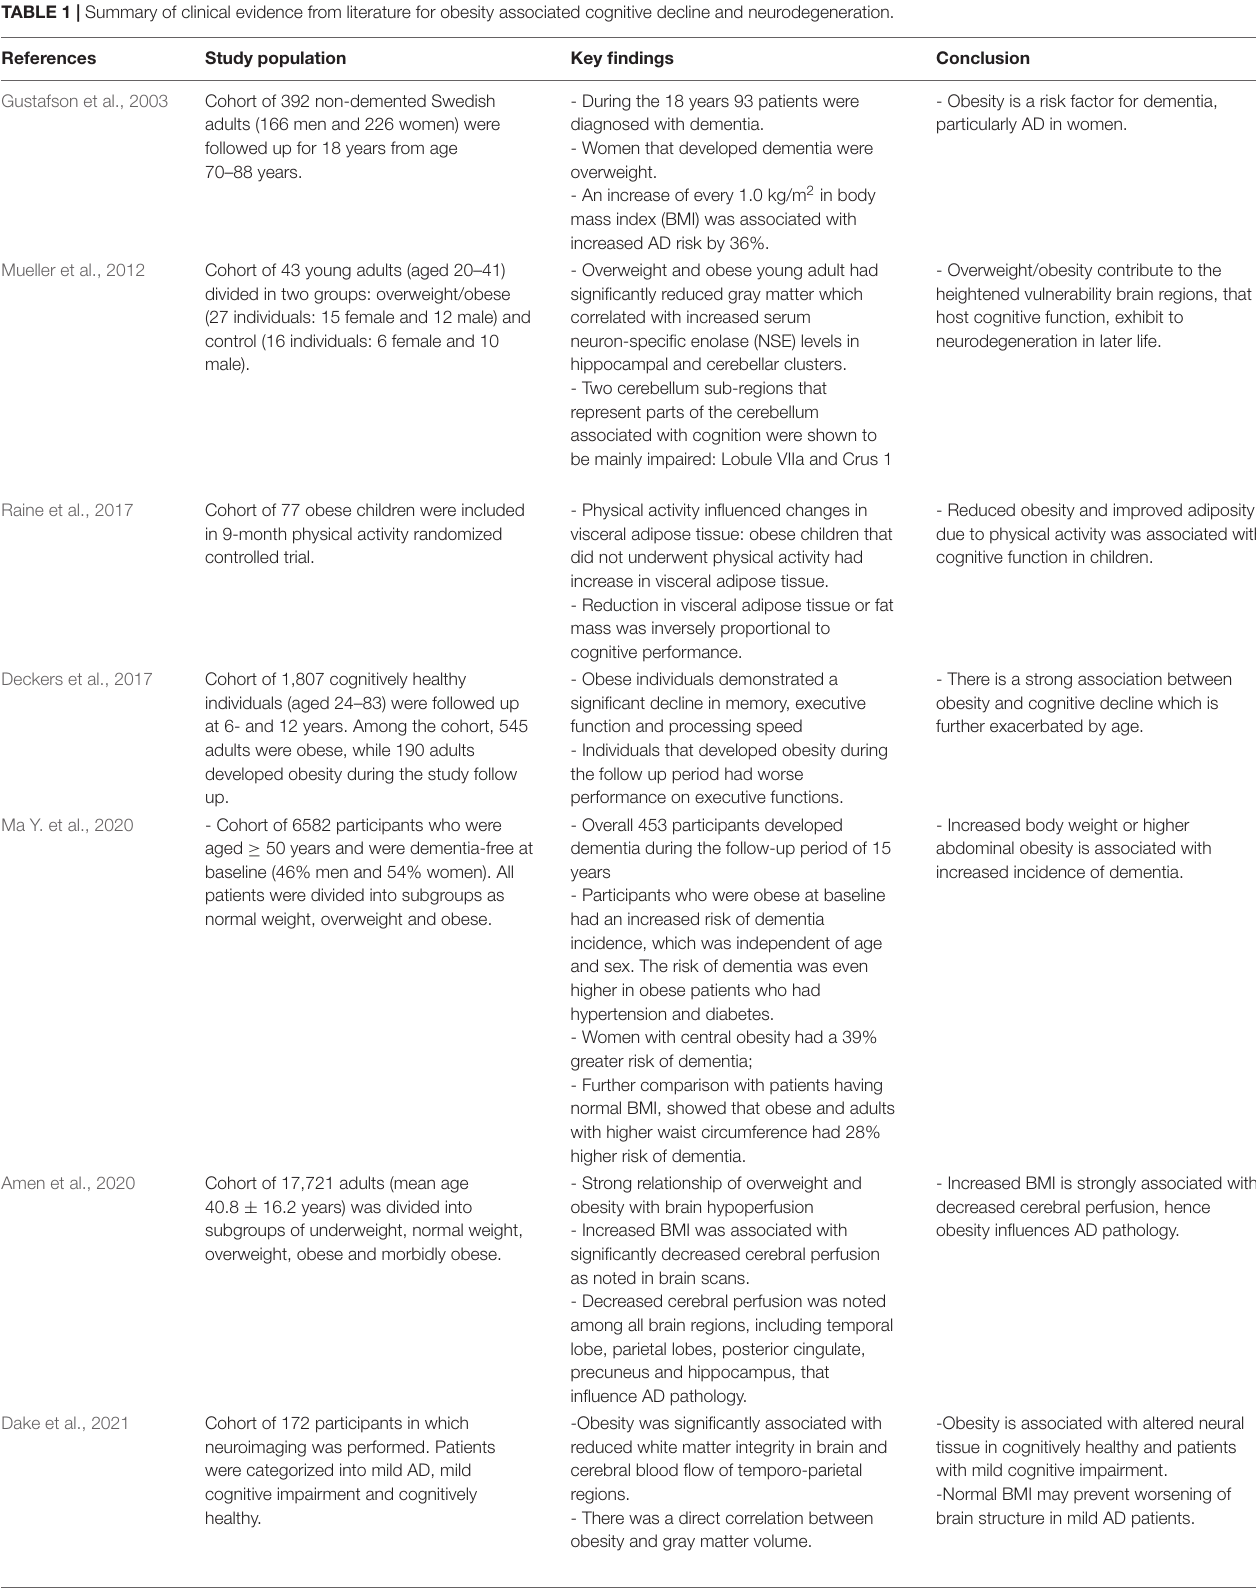
TABLE 1 | Summary of clinical evidence from literature for obesity associated cognitive decline and